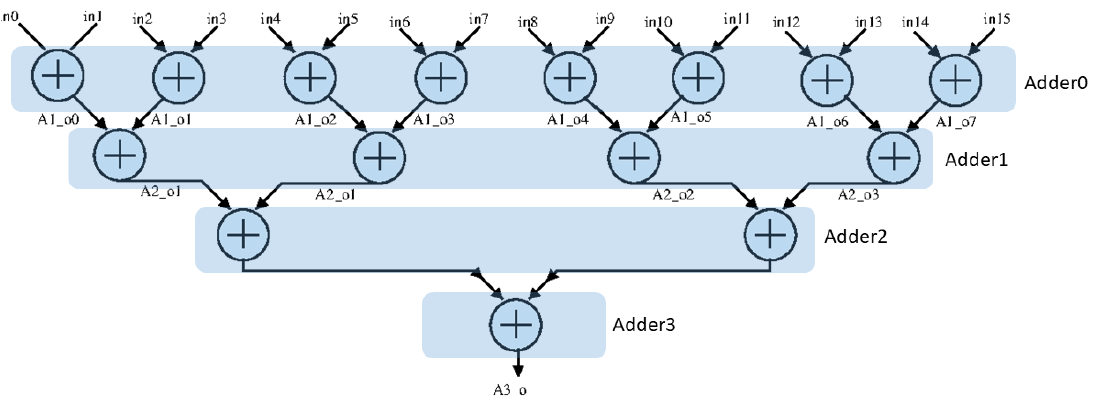
Figure 10. Four stage pipeline structure of the adder